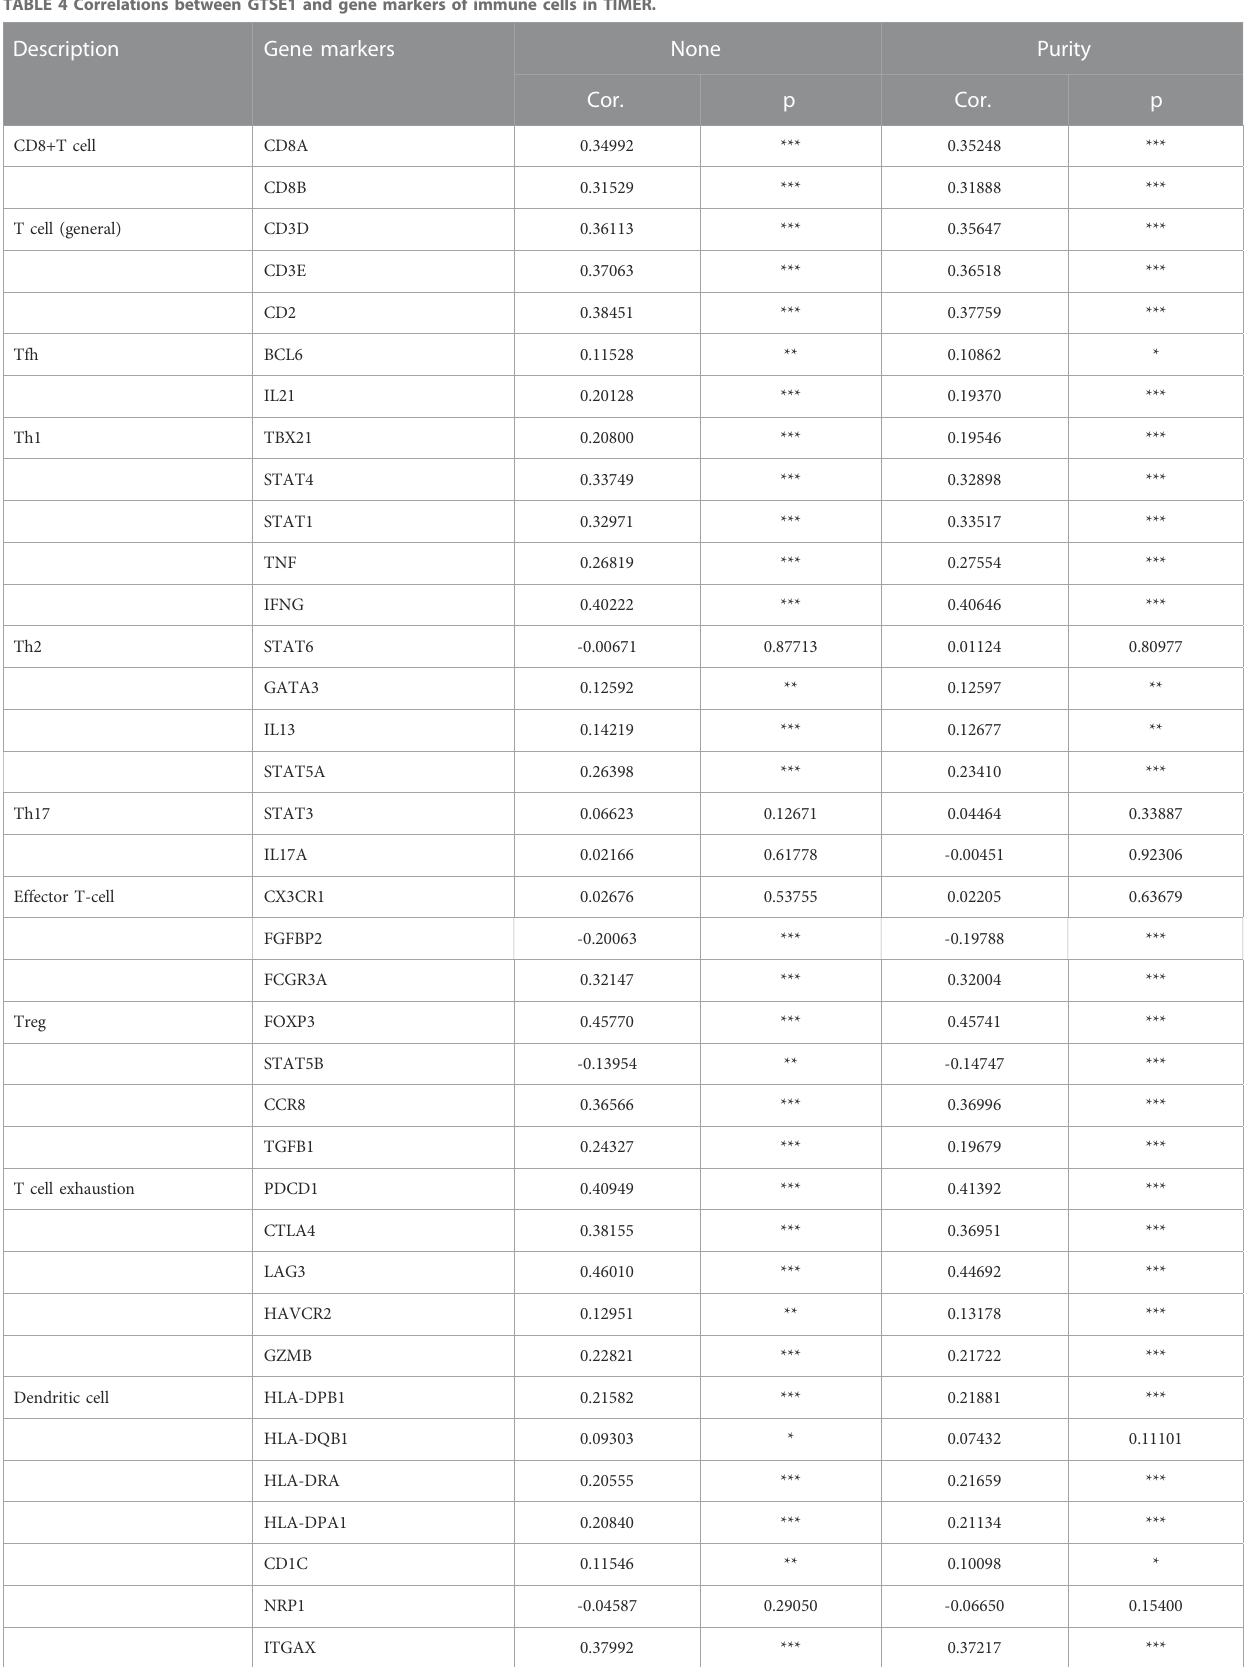
TABLE 4 Correlations between GTSE1 and gene markers of immune cells in TIMER.